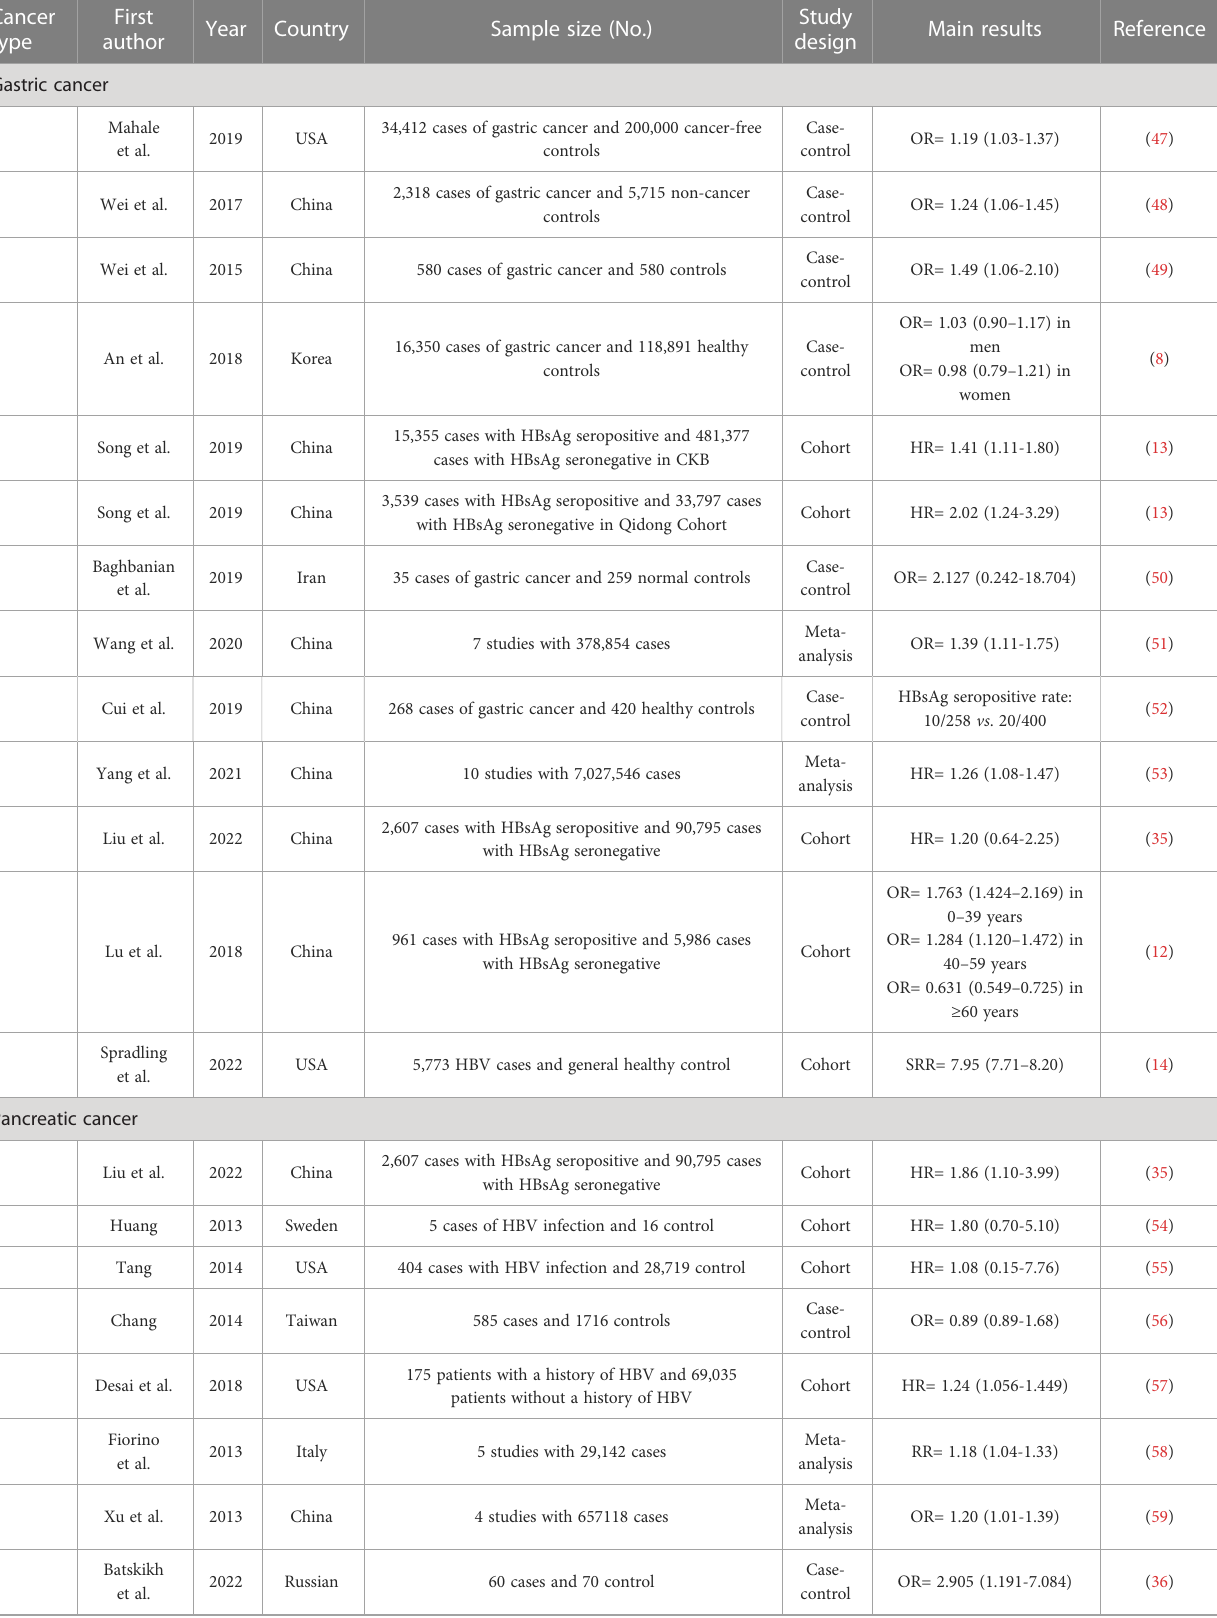
TABLE 1 The evaluation of associations between chronic HBV infection and extrahepatic cancers in recent